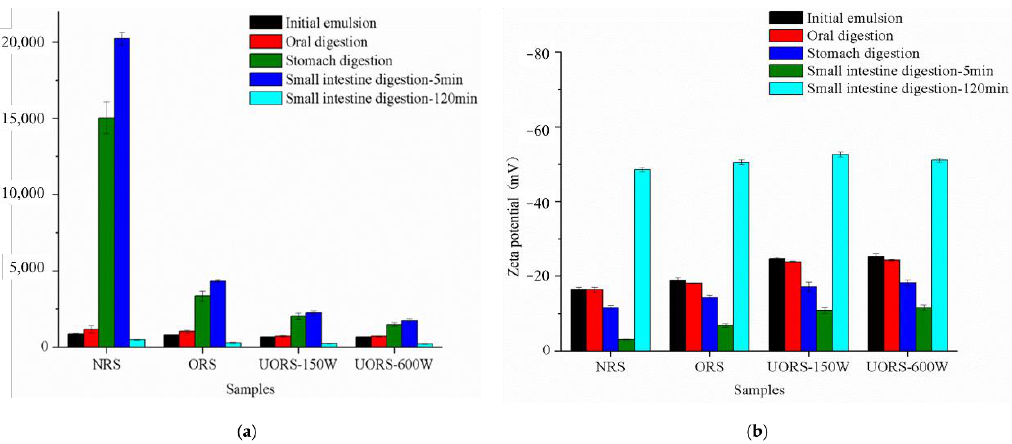
Figure 1. Particle size variation ( a ) and Zeta potential variation ( b ) of curcumin emulsions stabilized by native rice starch and OSA rice starch during in vitro digestion.